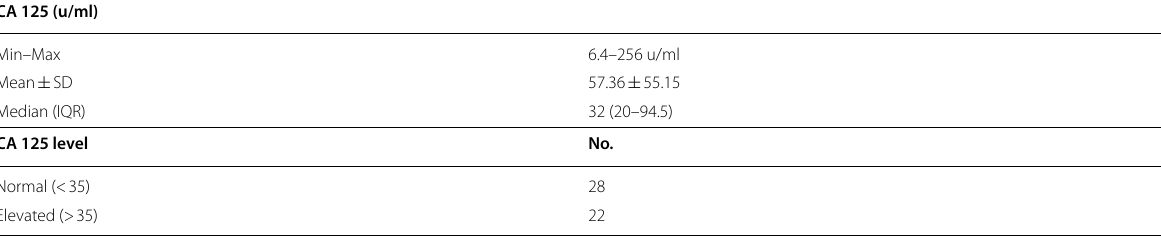
Table 2 Distribution of CA 125 level of all studied cases